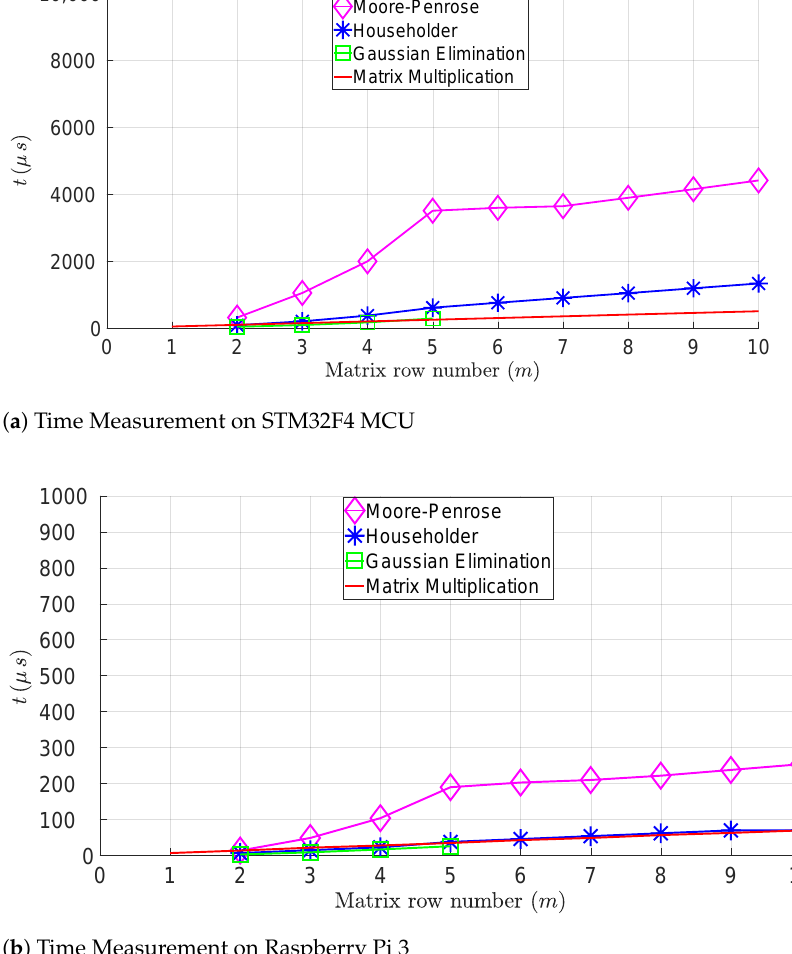
Figure 4. Computing time evaluation of matrix multiplications and linear equation